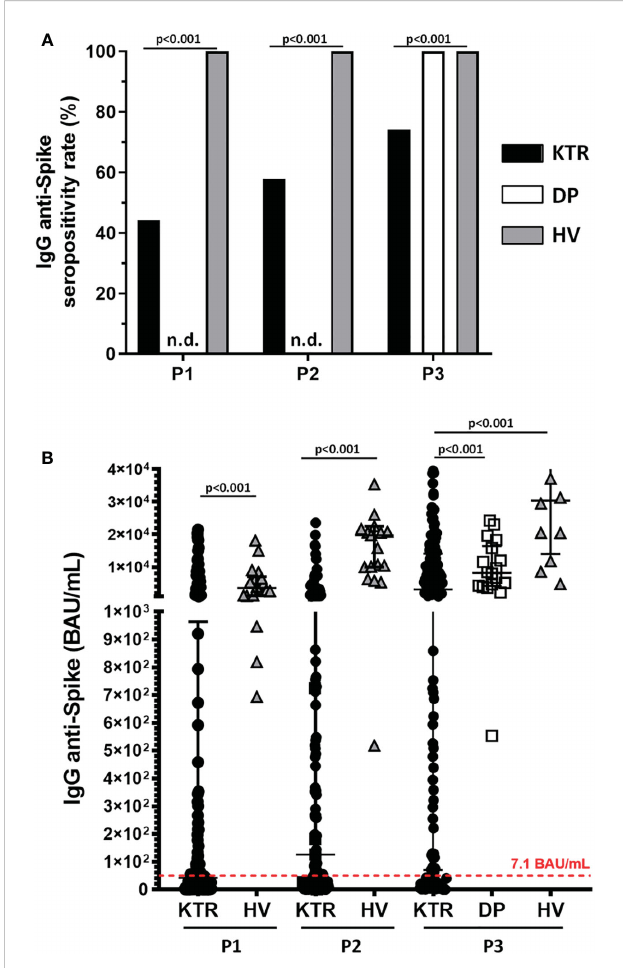
FIGURE 3 Kidney transplant recipients have lower humoral response rates and lower antibody titers after vaccination. (A) Seropositivity rate after vaccination in patients (KTR) and control groups (dialysis, PD; and healthy volunteers, HV) for each sample collection after vaccine administration. A threshold of >7.1 BAU/mL was used to consider seropositivity. (B) Antibody levels (BAU/mL) for each sampling and group after vaccine administration. Serum anti-spike IgG titers were higher in HV compared to KTR after second dose: 1782.8 (719.2- 2519.2 IQR) vs 4.4 (0.3-135.6 IQR) BAU/mL at P1 (p<0.001), 394.3 (179.1-850.6 IQR) vs 18.3 (1.2-140.3 IQR) BAU/mL at P2 (p<0.001) and after the third dose: 335.5 (7.1-1415.3 IQR) BAU/mL in KTR, 908.9 (457.8-1872.8 IQR) BAU/mL in DP, 3058.9(1405.4-4366.1 IQR) BAU/ mL in HV, p<0.001 Data were expressed as median and IQR, and p-values for each Mann-Whitney U test. n.d.,